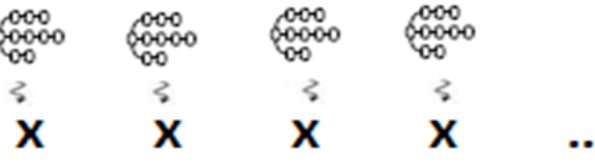
Figure 5: PFAC algorithm. Generating a thread for each character in the input